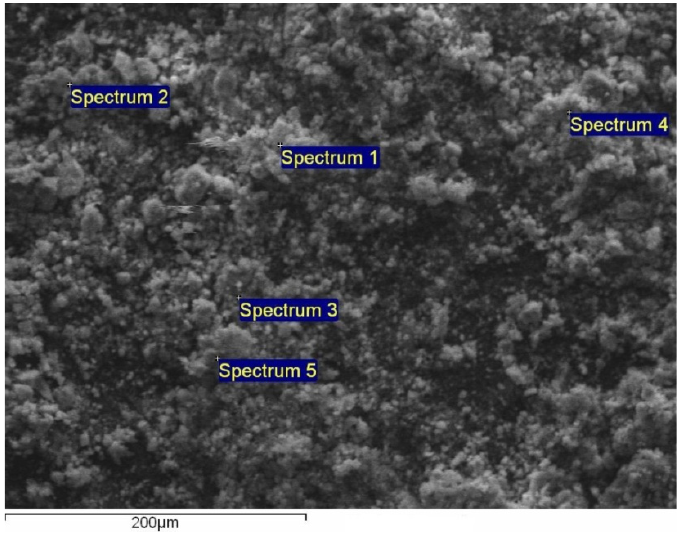
Figure 2. Representative SEM micrograph of TMFx‐50 catalyst. Table 2. Major physicochemical characteristics of modified TMFx catalysts.